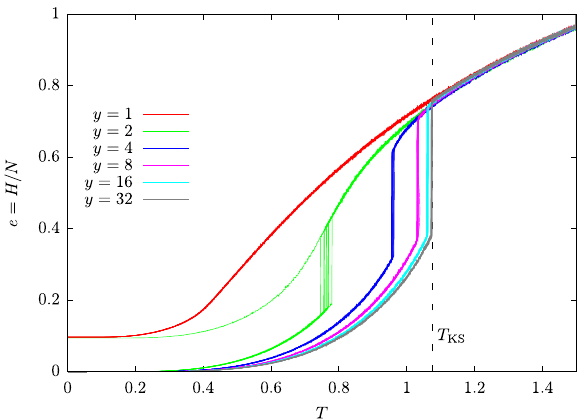
FIG. 4. The energy density as a function of the temperature in the replicated simulated annealing for planted coloring with q ¼ 5 , N ¼ 10 5 , dT ¼ 10 − 7 , and c ¼ 17 , changing the number y of replicas. For each value of y , ten different samples are simulated. For y ¼ 1 SA does not find the planted solution, while RSA finds it as long as y > 1 RSA finds it. The vertical line represents T as found by the linearization of BP equations KS around the PM solution in the limit y → ∞ .